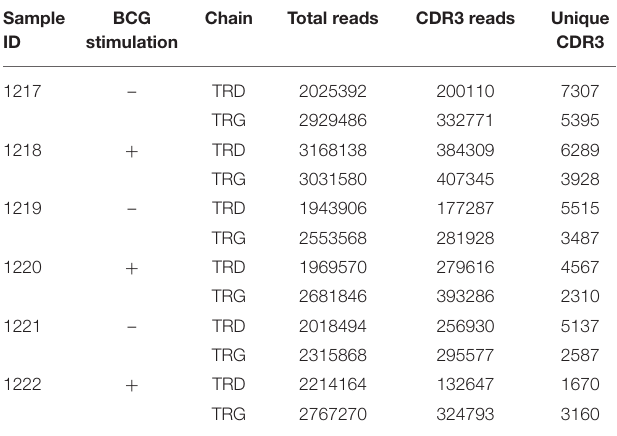
TABLE 1 | General information of the peripheral blood γδ T cell receptor repertoire in healthy individuals stimulated by BCG in vitro . Sample ID